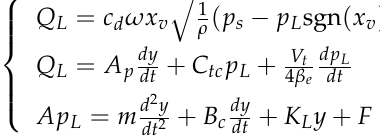
Figure 2. Structure diagram of zero opening four ‐ way slide valve.